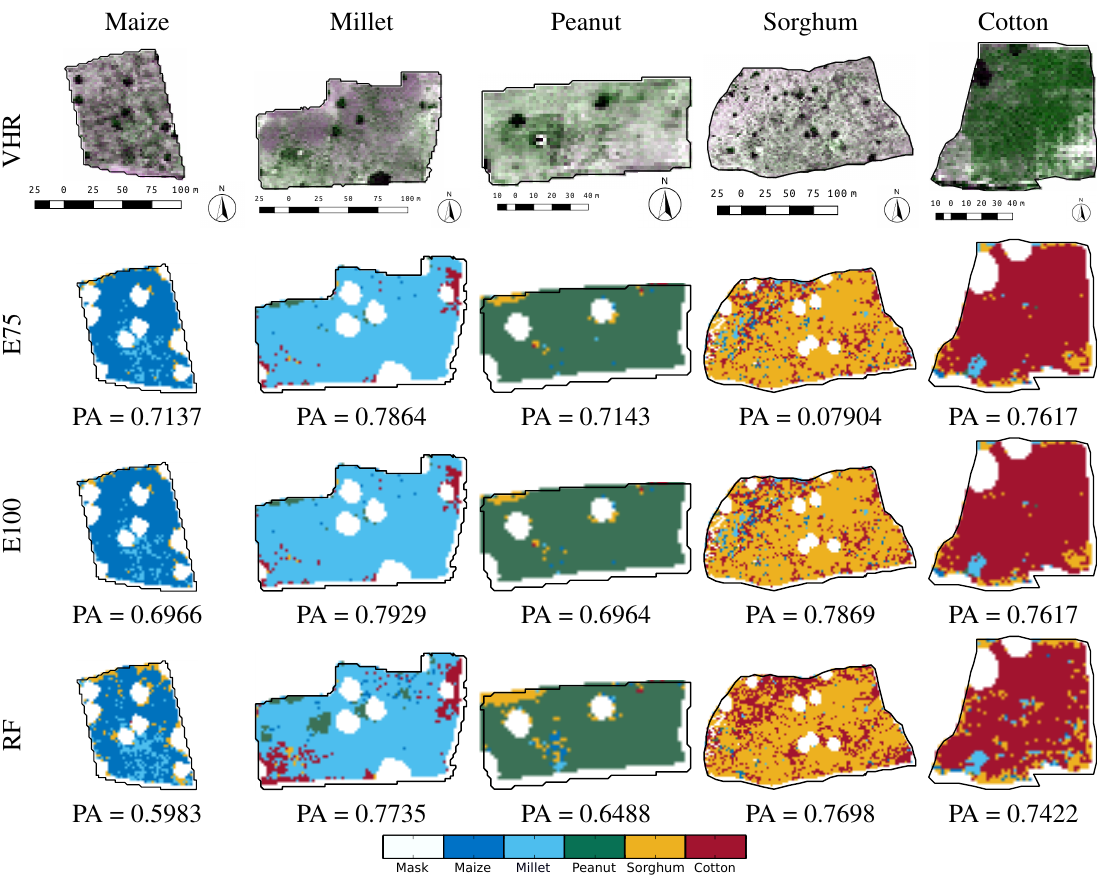
Figure 8. Comparison between field classifications produced by a 75-classifiers ensemble (E75), the 100-classifiers ensemble (E100), and a random forest classifier (RF). PA: Accuracy per class is listed below each crop. Mask corresponds to trees inside fields or clouds. VHR: overlapping area in a World-View2 image on 7 July 2014 using natural color